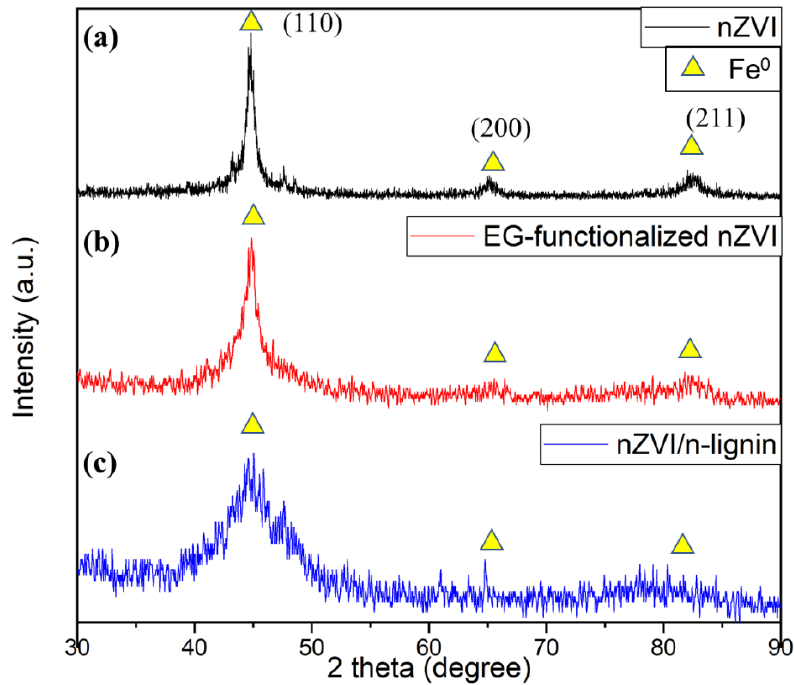
Figure 5. XRD analysis: ( a ) bare nZVI, ( b ) EG-functionalized nZVI, and ( c ) nZVI/n-lignin.